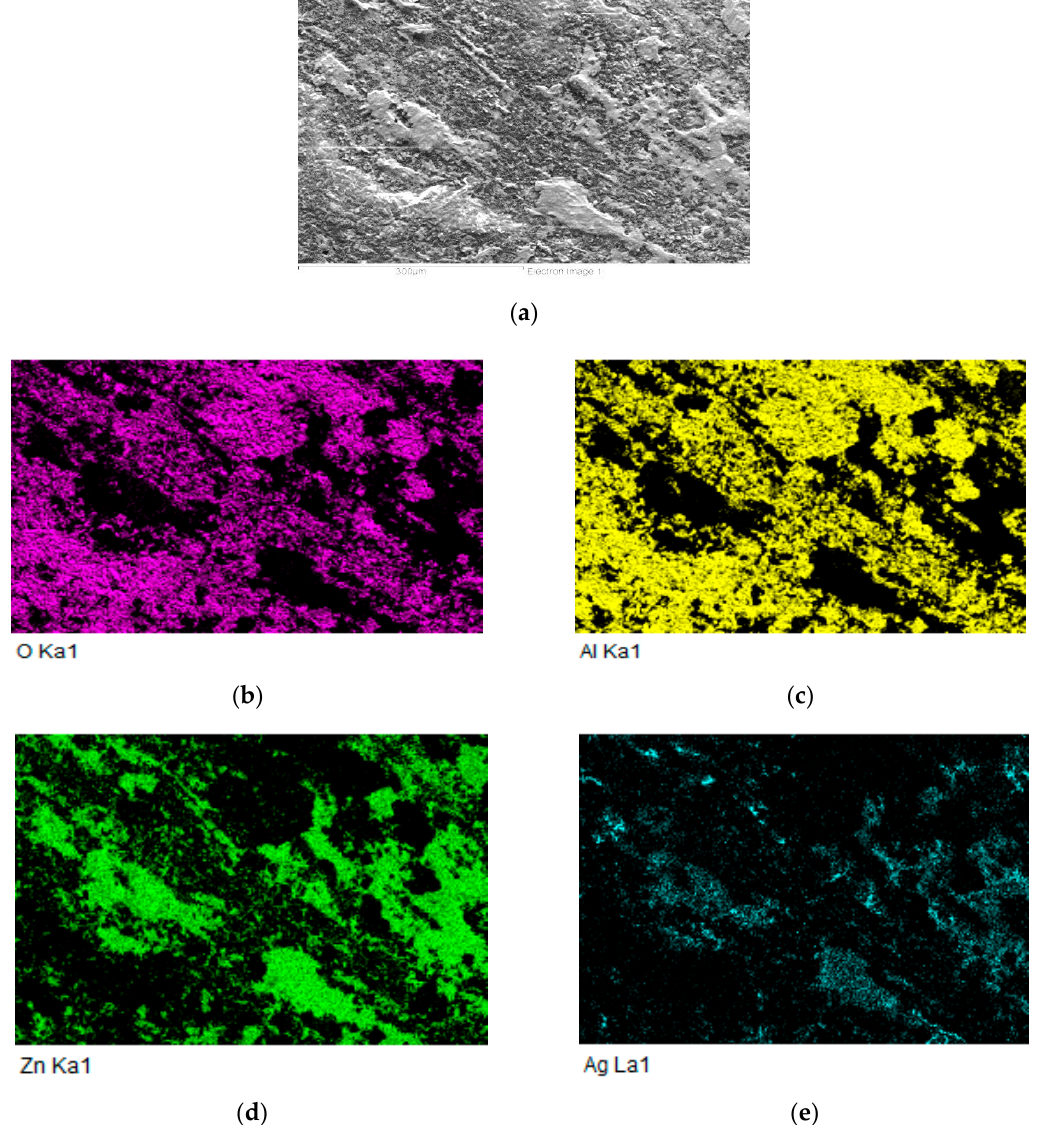
Figure 15. Planar analysis of elements on the fractured surface of Al 2 O 3 /Zn6Al6Ag joint: ( a ) fracture morphology; elements ( b ) O, ( c ) Al, ( d ) Zn, and (e) Ag.